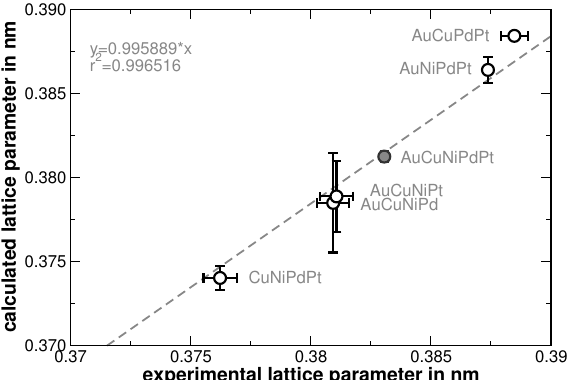
Figure 2. Lattice parameters of the quaternary and quinternary equiatomic solid solutions in the system Au-Cu-Ni-Pd-Pt. The dashed line represents a linear fit to the